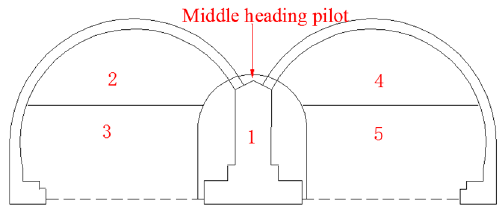
Figure 3. Schematic diagram of the central heading method in class III rock masses.